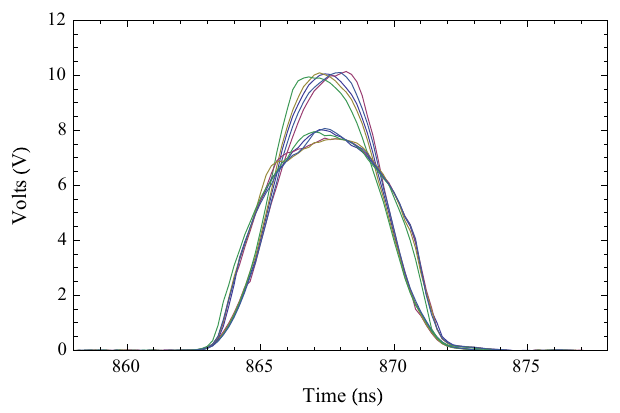
FIG. 12. All the traces which are collected before and after the seventh modulation are plotted together here. This clearly shows the shape change at the end of the